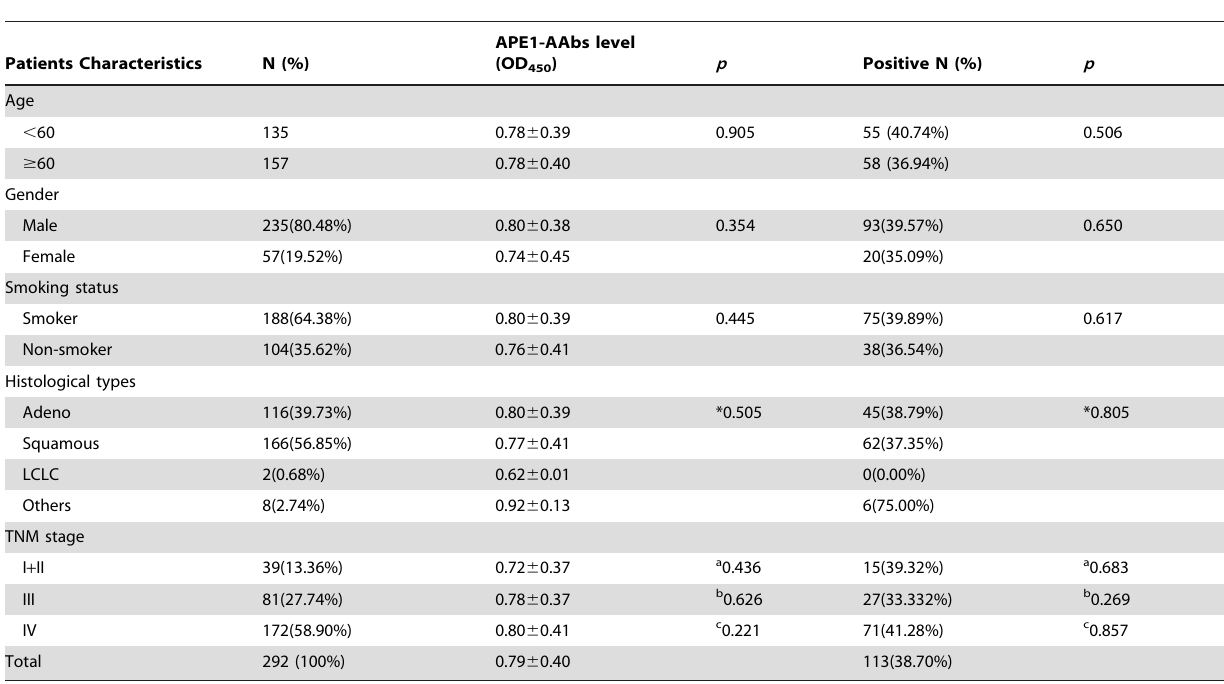
Table 2. Association of serum APE1-AAbs level with clinical characteristics among NSCLC groups.